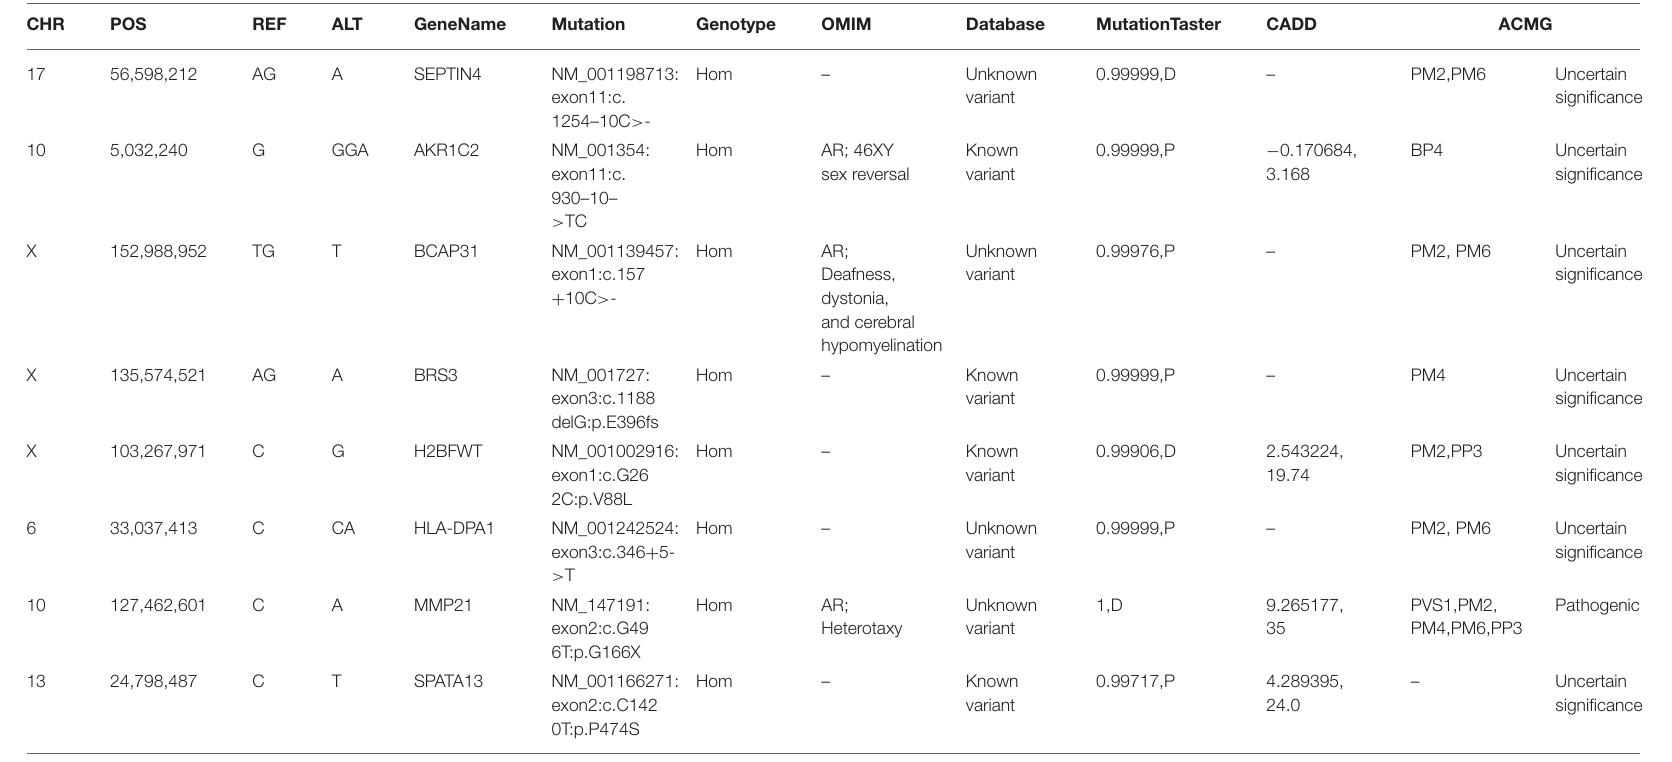
TABLE 1 | The gene list after WES data filtration of the patient.